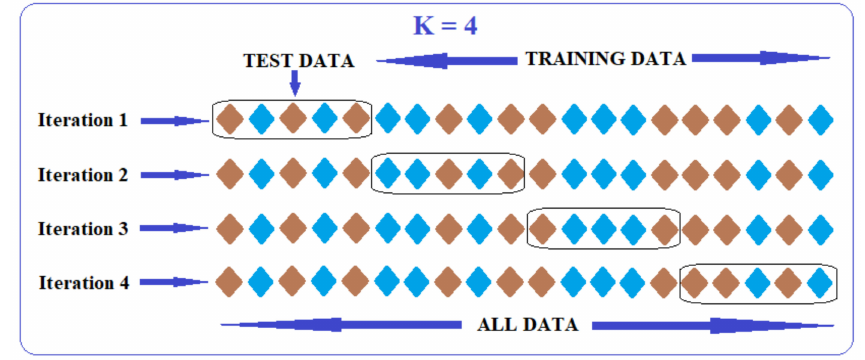
Figure 12. Graphical representation of K-fold